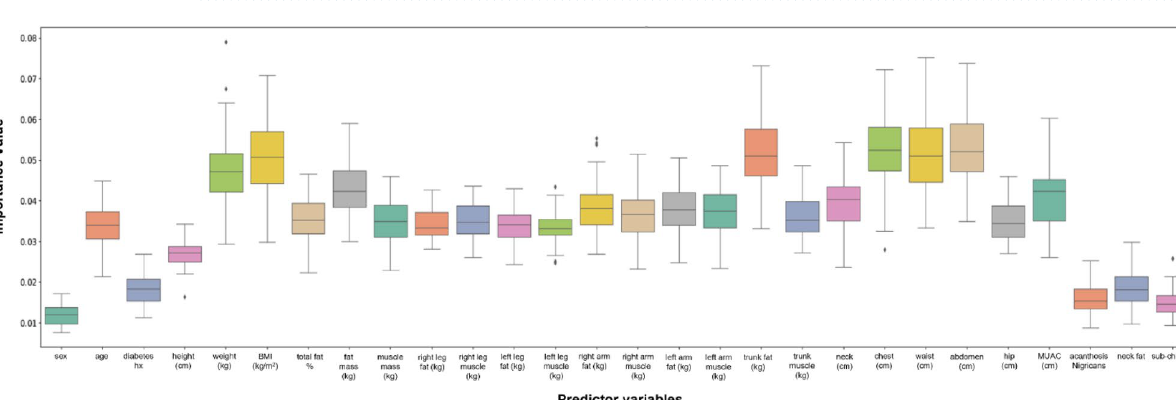
Figure 4. Box plots showing relative feature importance for presence of fatty liver. hx history, cm centimeter, kg kilograms, BMI body mass index, MUAC mid-upper arm circumference.